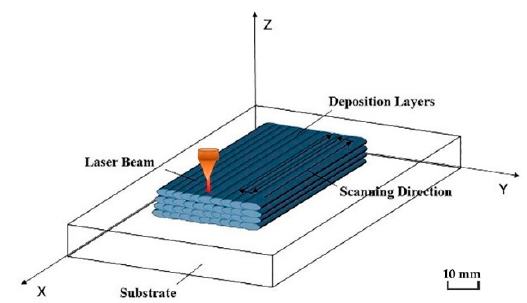
Figure 1. Schematic diagram of laser cladding deposition.